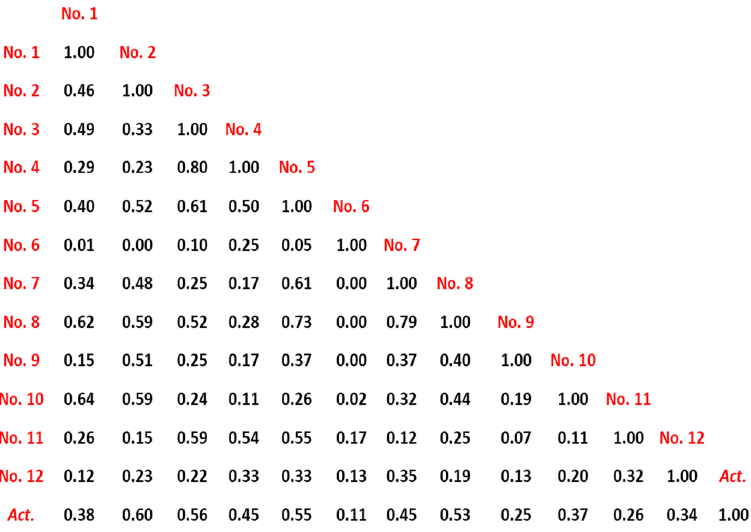
Figure 1. The correlations matrix for the selected 12 descriptors along with catalytic activity.